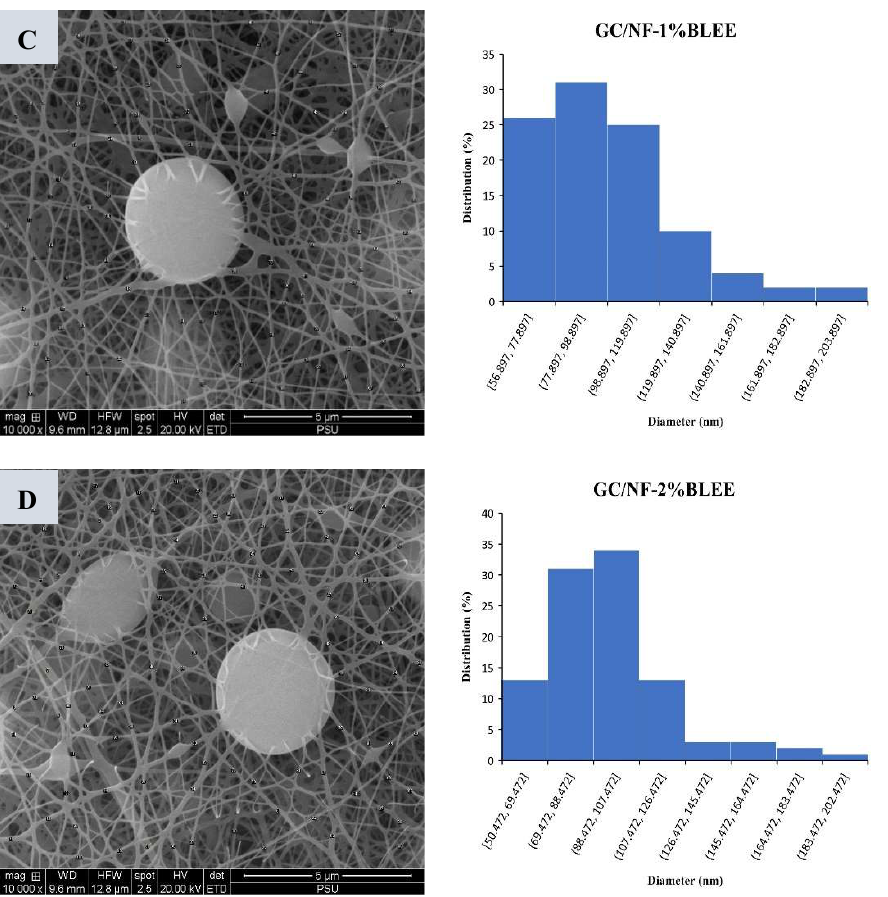
Figure 1. Scanning electron microscopic (SEM) images and histograms representing nanofiber diameter distributions coated on the PLA films containing betel leaf ethanolic extract (BLEE) at 0% ( A ), 0.5% ( B ), 1% ( C ), and 2% ( D ).